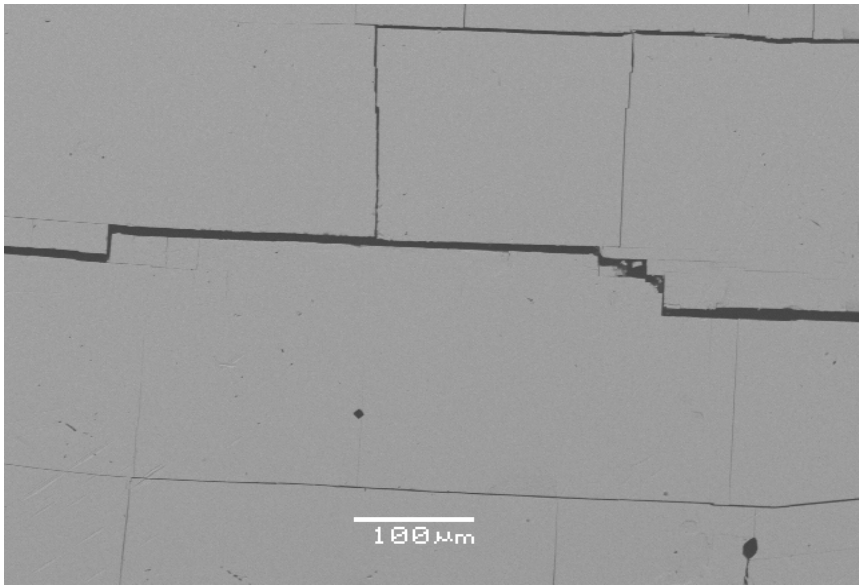
Figure 2. Backscattered electron (BSE) image of polished section from Stratoni PbS concentrate.